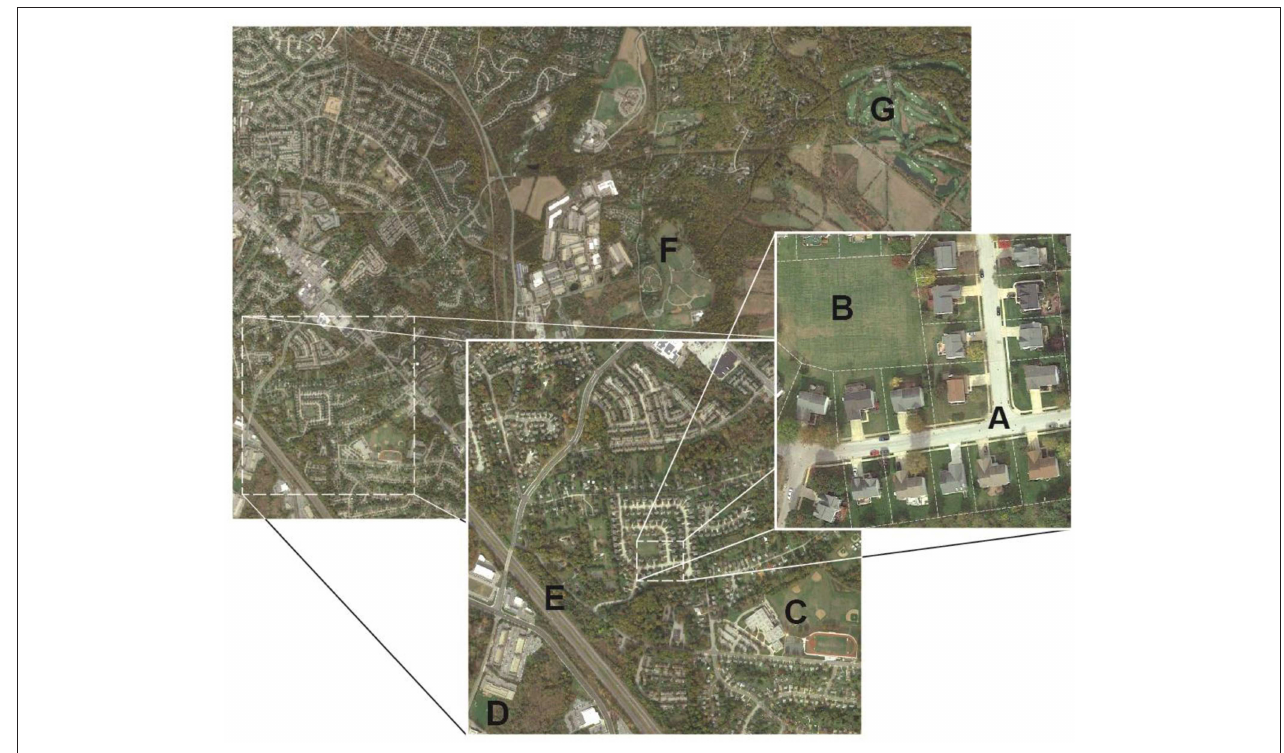
FIGURE 1 | Urban grasslands encompass a range of landscape types, management intensities, and landscape scales including those associated with: (A) residential development, (B) parks and recreational spaces, (C) school athletic fields, (D) institutional campuses, (E) roadsides and medians, (F) civic grounds, and (G) golf courses. While the land-uses and management goals and social drivers of urban grasslands differ, common maintenance practices can have discernable effects on local and regional carbon (C) and nitrogen (N) dynamics and associated soil